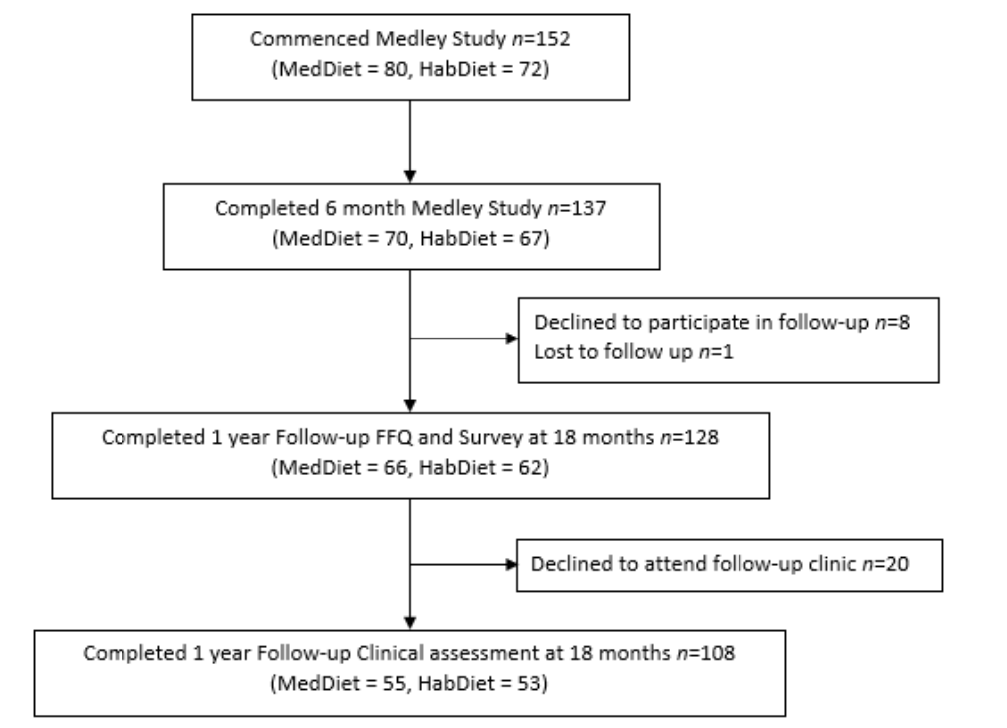
Figure 1. Consort flow diagram for participation in the MedLey study and the subsequent follow-up study.